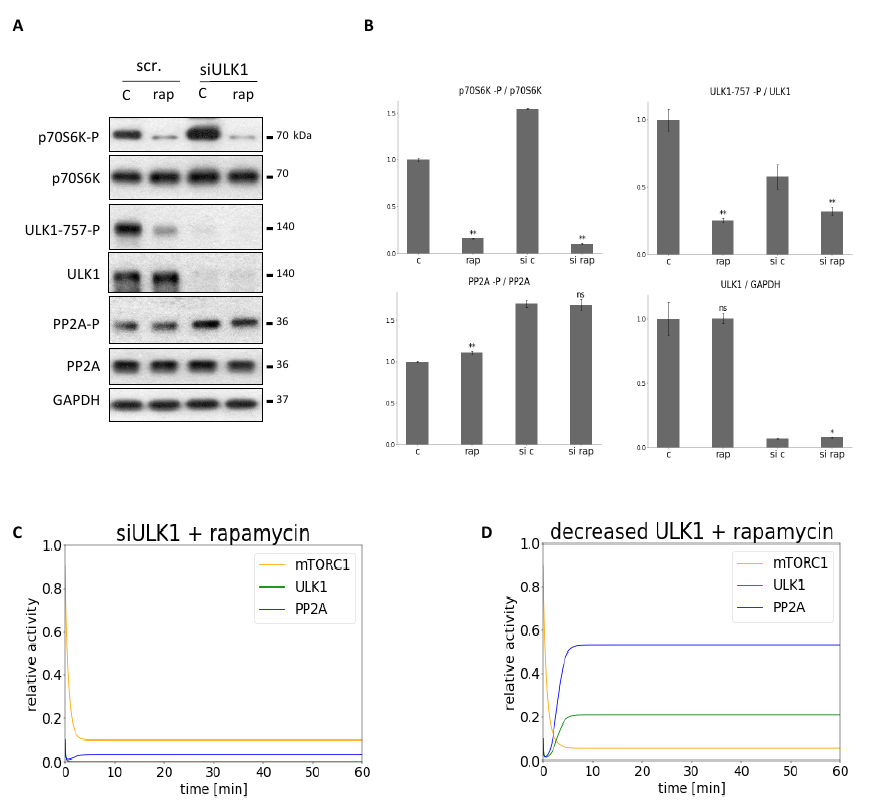
Figure 5. Combined down-regulation of mTORC1 and ULK1 can result in PP2A inhibition. ULK1 was silenced in HEK293T cells, then cells were treated with/without 100 nM rapamycin for 2 h. The silencing was checked by using a scramble siRNA. ( A ) The markers of ULK1 (ULK1-757-P), PP2A (PP2A-P) and mTORC1 (p70S6K-P) were followed by immunoblotting. GAPDH was used as loading control. ( B ) Densitometry data represent the intensity of ULK1-757-P normalized for total level of ULK1, PP2A-P normalized for total level of PP2A and p70S6K-P normalized for total level of p70S6K. For each of the experiments, three independent measurements were carried out. Error bars represent standard deviation asterisks indicate statistically significant difference from the control: ns—nonsignificant; *— p < 0.05; **— p < 0.01. The computational simulation is determined upon two different types of